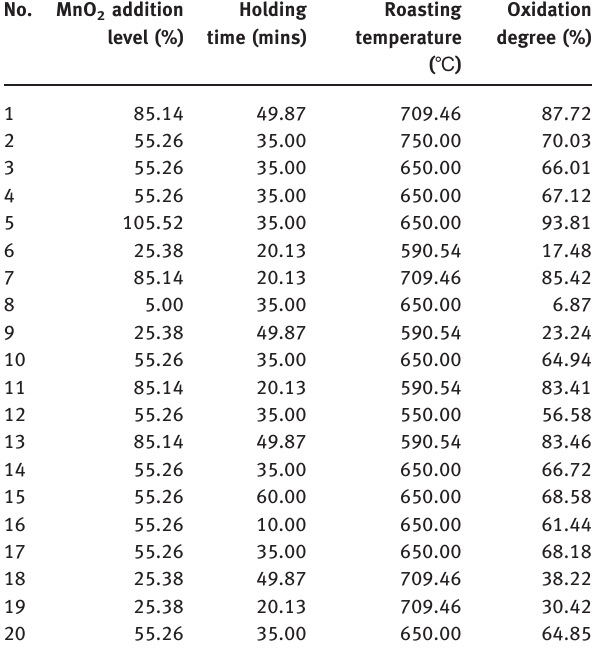
Table 3: Central composite design arrangement and results of microwave-assisted oxidation roasting of oxide – sulphide zinc ore with addition of manganese dioxide.